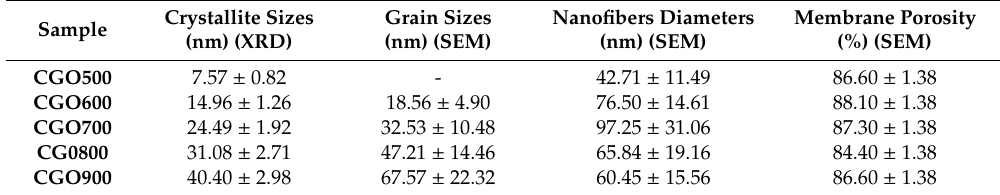
Table 1. Main properties determined by XRD and